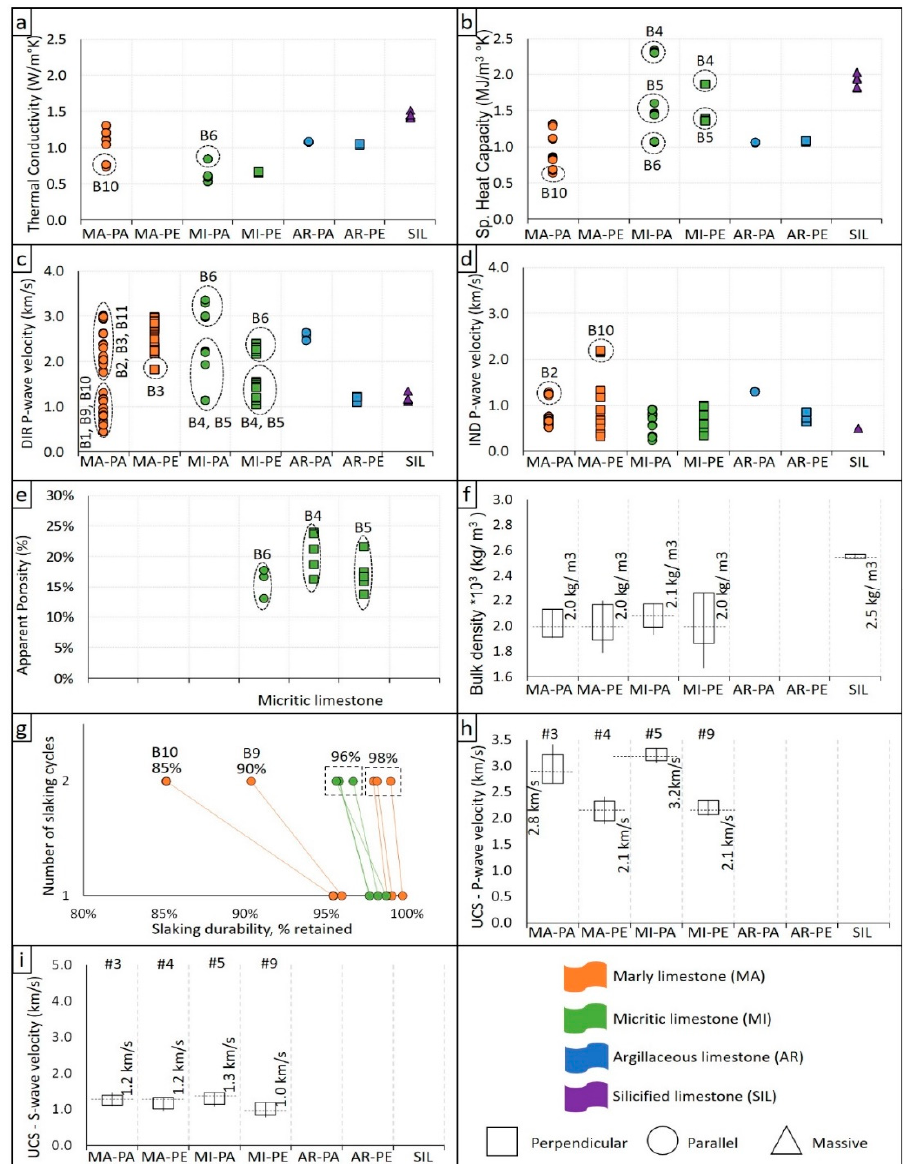
Figure 5. Test results for block samples characterised by lithology and test orientation. The results for ( a ) thermal conductivity, ( b ) specific heat capacity, ( c ) P-wave velocity in the direct (DIR) technique, ( d ) P-wave velocity in the indirect (IND) technique, ( e ) apparent porosity, ( f ) bulk density, ( g ) slake durability index for the second cycle, ( h ) P-wave velocity measured in UCS samples, and ( i ) S-wave velocity measured on UCS samples are shown. MA: marly limestone; MI: micritic limestone; AR: argillaceous limestone; SIL: silicified limestone; PA: parallel; PE: perpendicular.